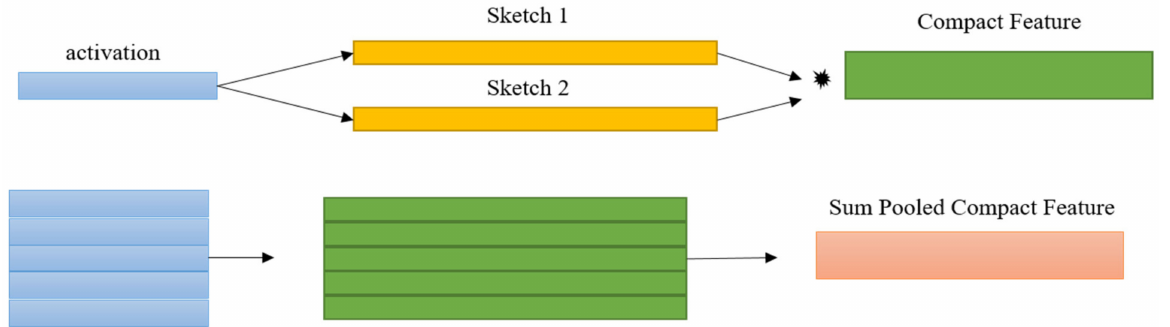
Figure 5. Image identification using the compact bilinear pooling